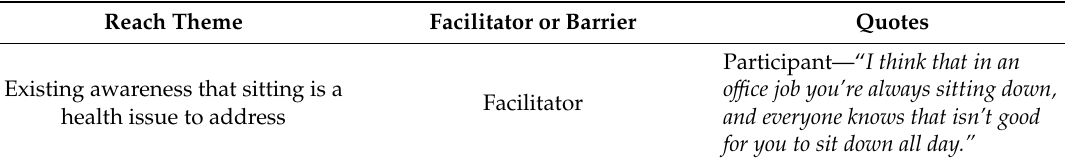
Table 6. Qualitative themes relating to indicators of